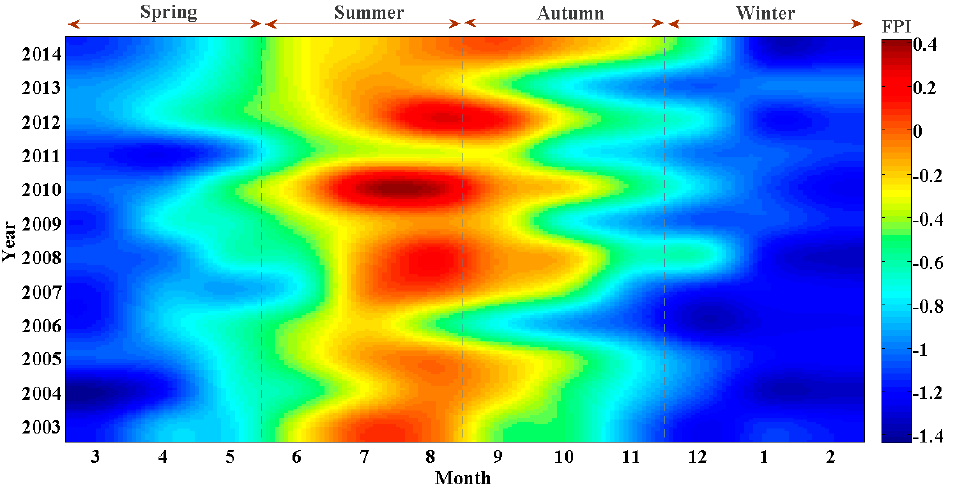
Figure 8. Seasonal variations of flooding (flood potential index, FPI) in the Yangtze River Basin from 2003 to 2014.